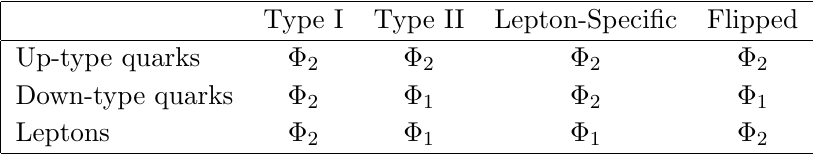
Table 1 . Classi(cid:12)cation of the Yukawa sector in the 2HDM according to the couplings of the fermions to the Higgs